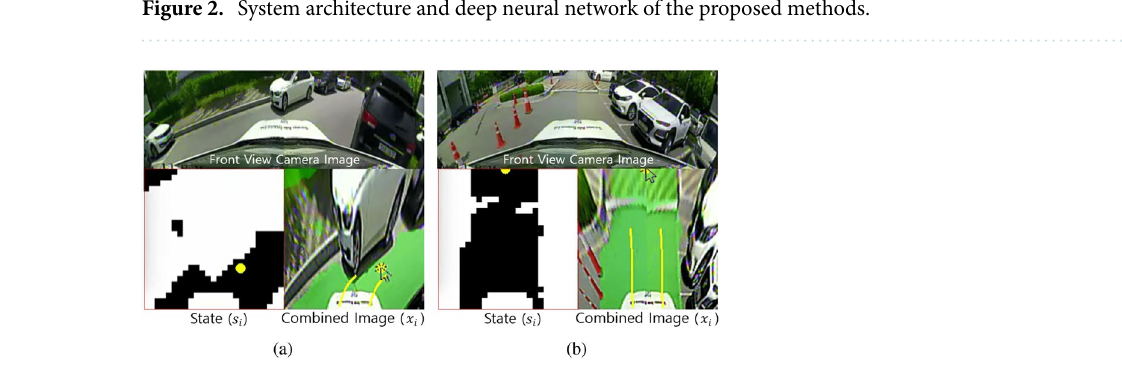
Figure 3. Dataset collection process of behavior cloning. The yellow look-ahead point is the action a exp , t selected by an expert. The expert selects a exp , t in the combined image x t . The yellow lines are the future trajectory that the vehicle will drive towards a exp , t along during a certain